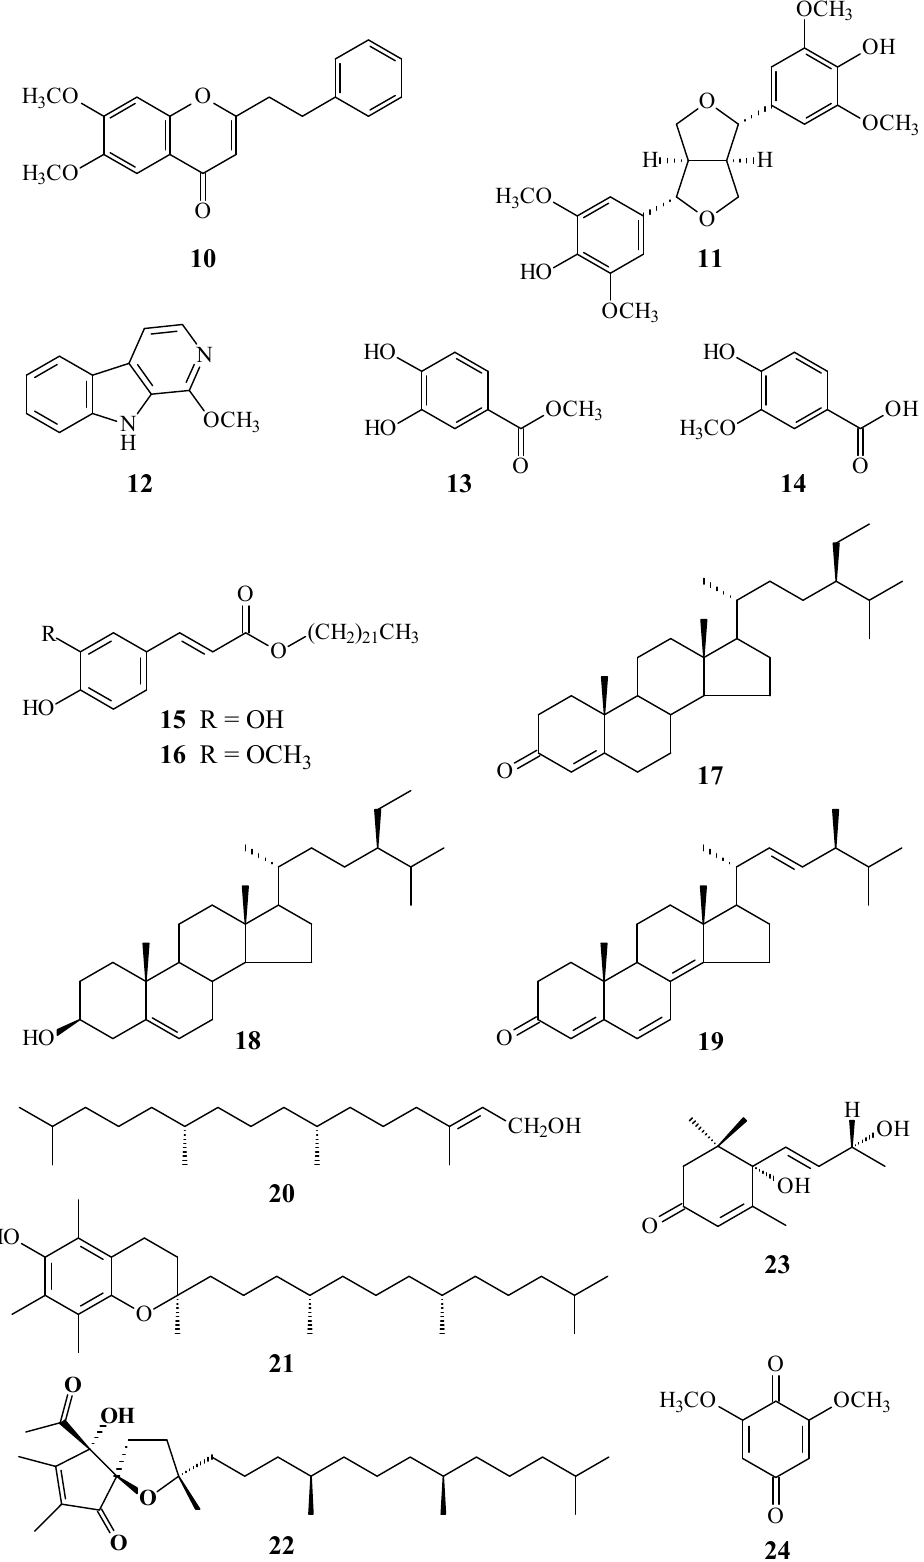
Figure 1. The chemical structures of new compounds 1 – 3 and known compounds 4 – 24 isolated from A. sinensis .